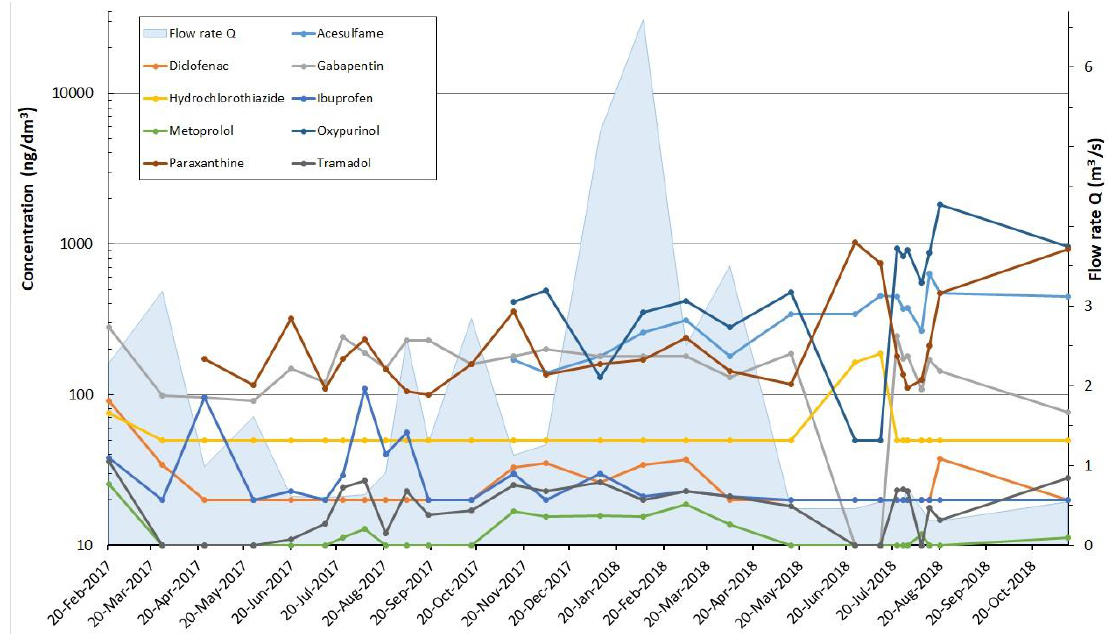
Figure 5. Monitoring results on Miletin profile (flow rates data [41]). Table 7. Miletin Profile — number of samples.